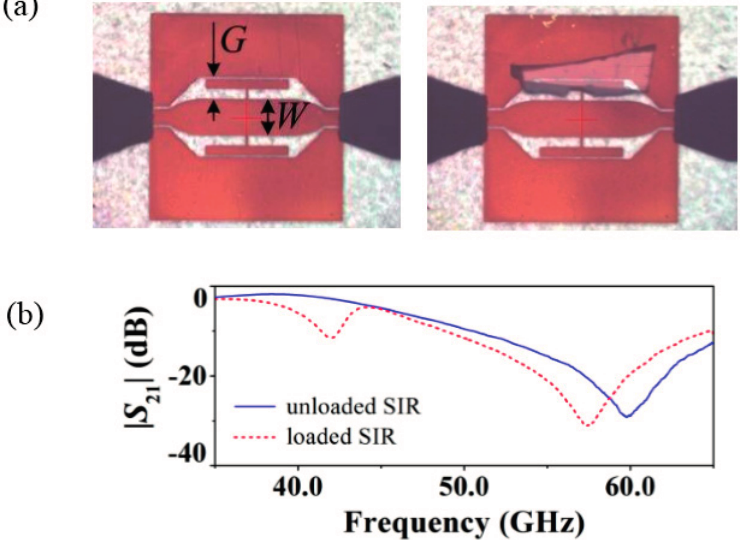
Figure 24. ( a ) Photograph of the proof-of-concept demonstrator without (left) and with (right) a piece of glass on the top; ( b ) measured transmission coefficient. CPW dimensions are: W = 350 µm and G = 210 µm. SIR dimensions are: l 1 = 90 µm and l 2 = 100 µm, and w 1 = 800 µm, w 2 = 20 µm ( l and w are the length and width of the sections, respectively). The substrate parameters are ε r = 4.6, h = 200 µm, and tan δ = 0.0021. From [34]; reprinted with permission from IEEE